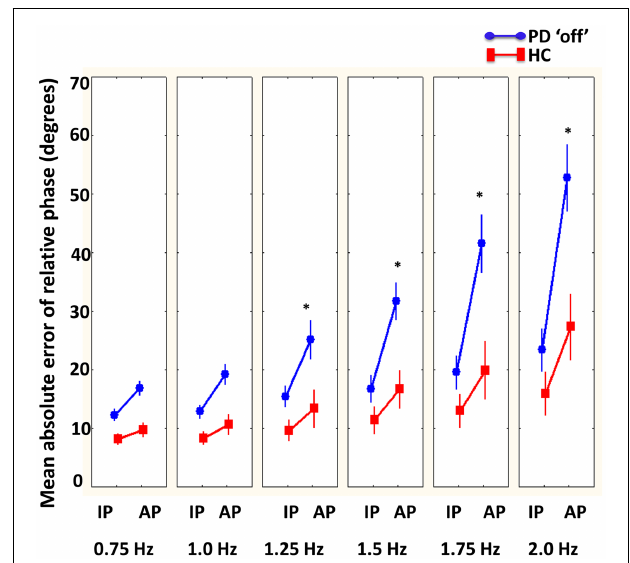
FIGURE 3 | Mean absolute error of relative phase (degrees) compared between PD “off” and healthy comparison (HC) participants as a function of phase (in-phase = IP and anti-phase = AP) and cycle frequencies . Results showed that HC had more accurate coordination compared to PD “off” participants at faster cycle frequencies (1.25–2Hz) in anti-phase (bars denote standard error). *Denotes significant differences between HC and PD “off” participants.